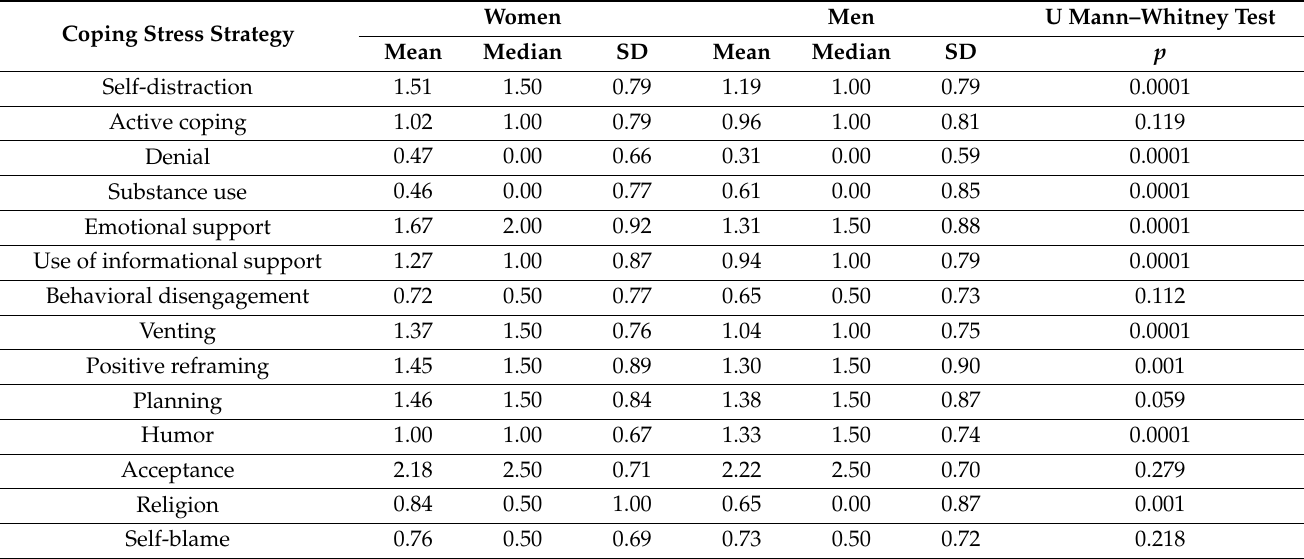
Table 3. The results of the most frequently chosen stress coping strategies for each